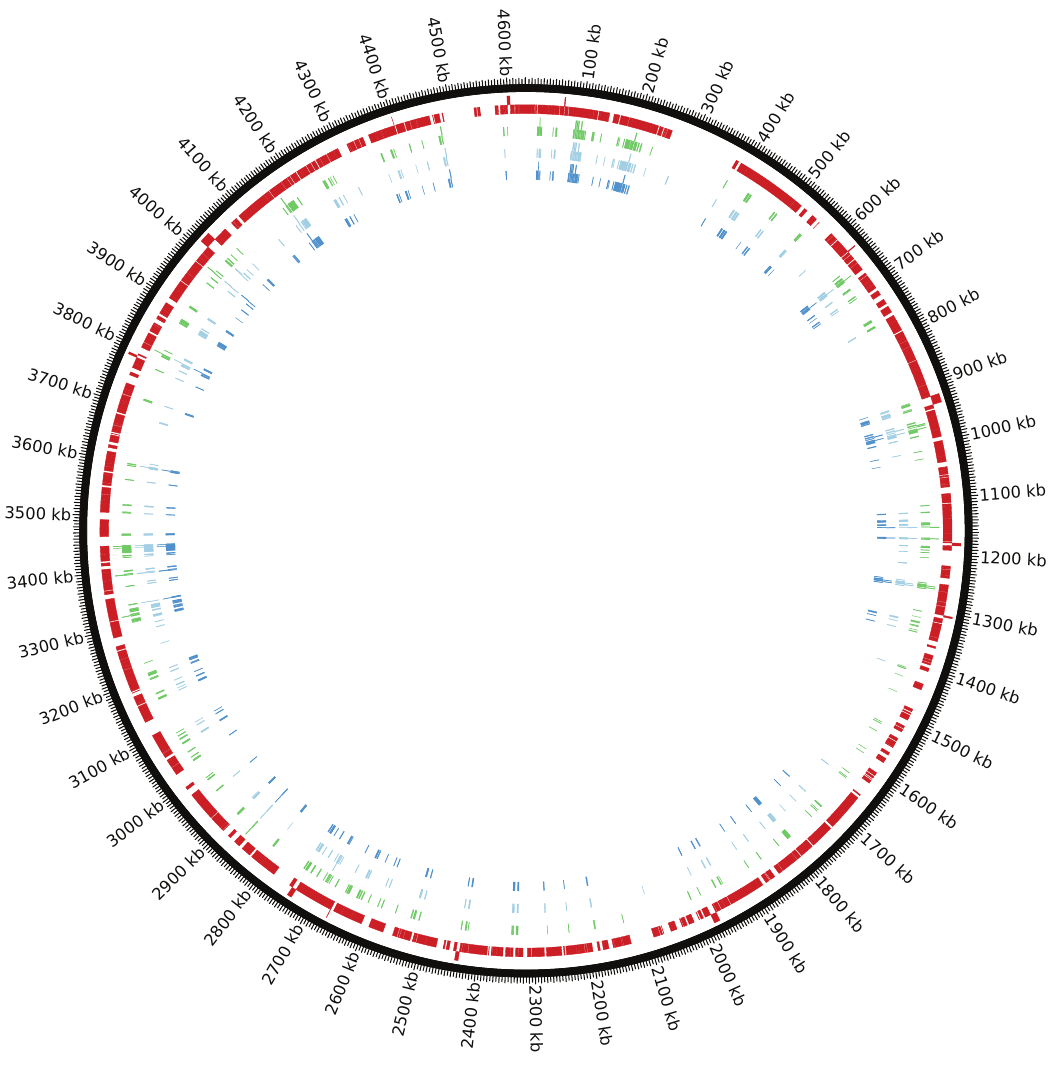
Figure 4. There are four tracks mapped to the E. coli reference genome in this Circos figure. Going from the outside to the inside: track 1) core regions (dark red), 2) TraDis essential genes (green), 3) Keio essential genes (light blue), and 4) PEC essential genes (medium